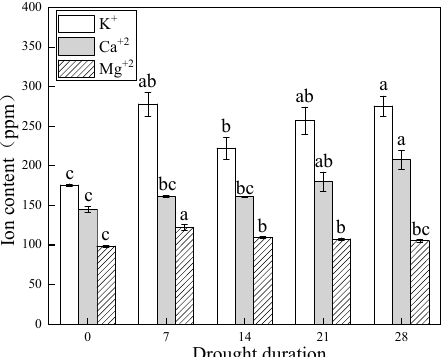
Figure 5. Changes in icon content with di ff erent durations of drought. K + (open bars) indicate K + concentrations, Ca + 2 (light-shaded bars) indicate Ca + 2 concentrations, Mg + 2 (hatched bars) indicate Mg + 2 concentrations. Di ff erent lower-case letters denote significance levels based on analysis of variance (ANOVA) post hoc means with least significant di ff erence (LSD) analysis ( p < 0.05). Data are means with standard error.